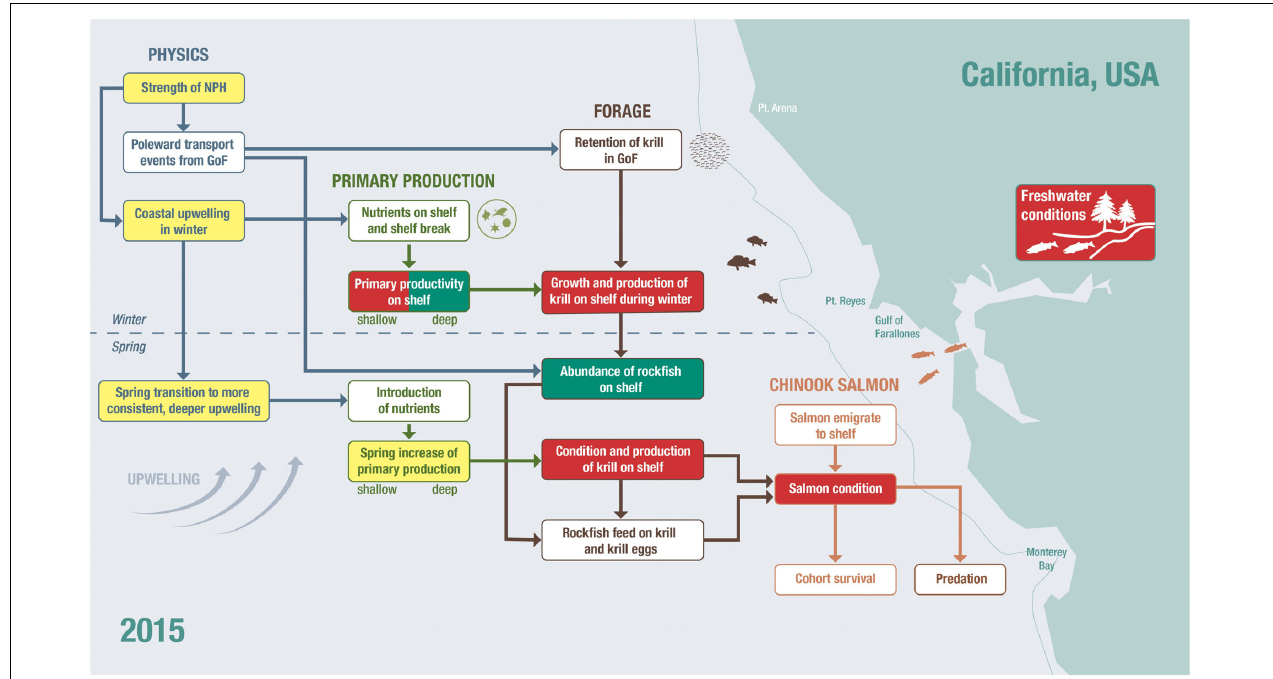
FIGURE 3 | The conceptual model represents the interactions within the ecosystem directly or indirectly affecting salmon survival at sea in central California (based on Wells et al., 2016). As an example of presenting risk of increased early mortality and recruitment in 2015, we have placed the state of individual indicators, previously identified as relating directly or indirectly to salmon survival onto the conceptual model and colored them according to whether they were average (yellow), below average (red), or above average (green) relative to their impact on